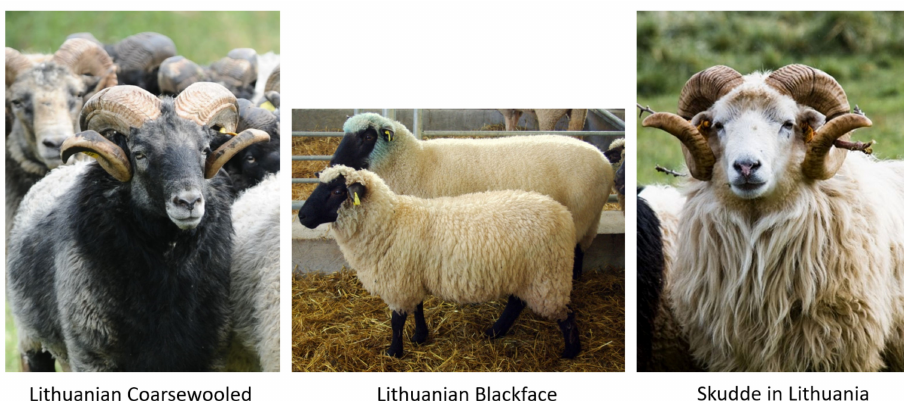
Figure 1. Pictures of two Lithuanian local sheep breeds and one imported Skudde sheep (Pictures made by A. Rackauskaite and K.